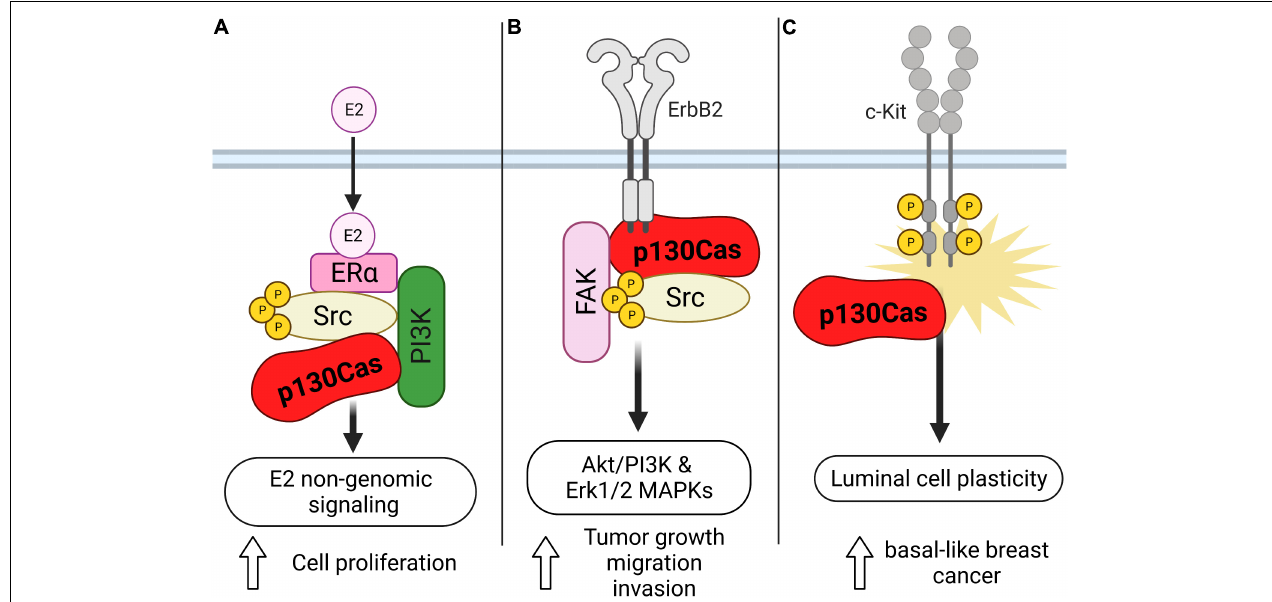
FIGURE 2 | Schematic representation of the role of p130Cas in the different types of breast cancer. (A) Upon estrogen treatment, p130Cas promotes cell proliferation mediated by the non-transcriptional activity of ER in T47D cells. In this context, p130Cas forms a complex with ERa, Src, and the p85 subunit of PI3K. (B) p130Cas/ERBB2 direct interaction stimulates the Akt/PI3K and Erk1/2 MAPKs pathways, facilitating tumor growth, cell migration, and invasion. (C) p130Cap expression promotes the hyperactivation of c-Kit in mouse mammary epithelial cells, inducing luminal cell